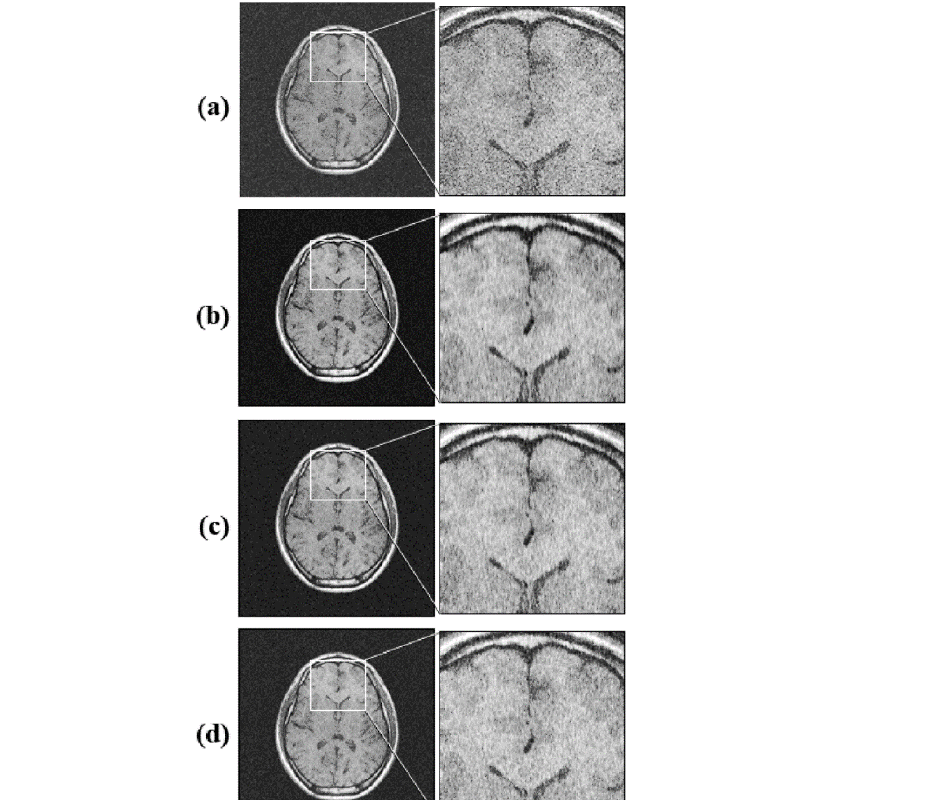
Table 2. Acquisition times for CSA techniques used in brain phantom imaging together with the numbers of phase-encoding lines in